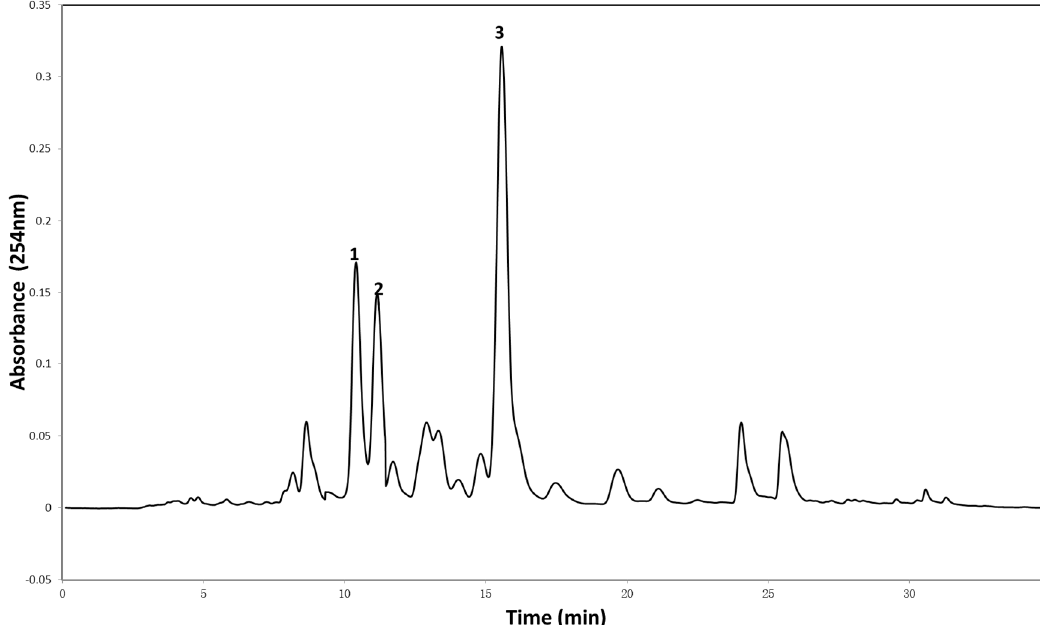
Figure 2. HPLC profile of the petroleum extract of P. pinnata and the compounds, pinnatin ( 1 ), 3,7-Dimethoxy-3 ′ ,4 ′ -methylenedioxy flavone ( 2 ), and karanjin ( 3 ), corresponding to the major peaks.